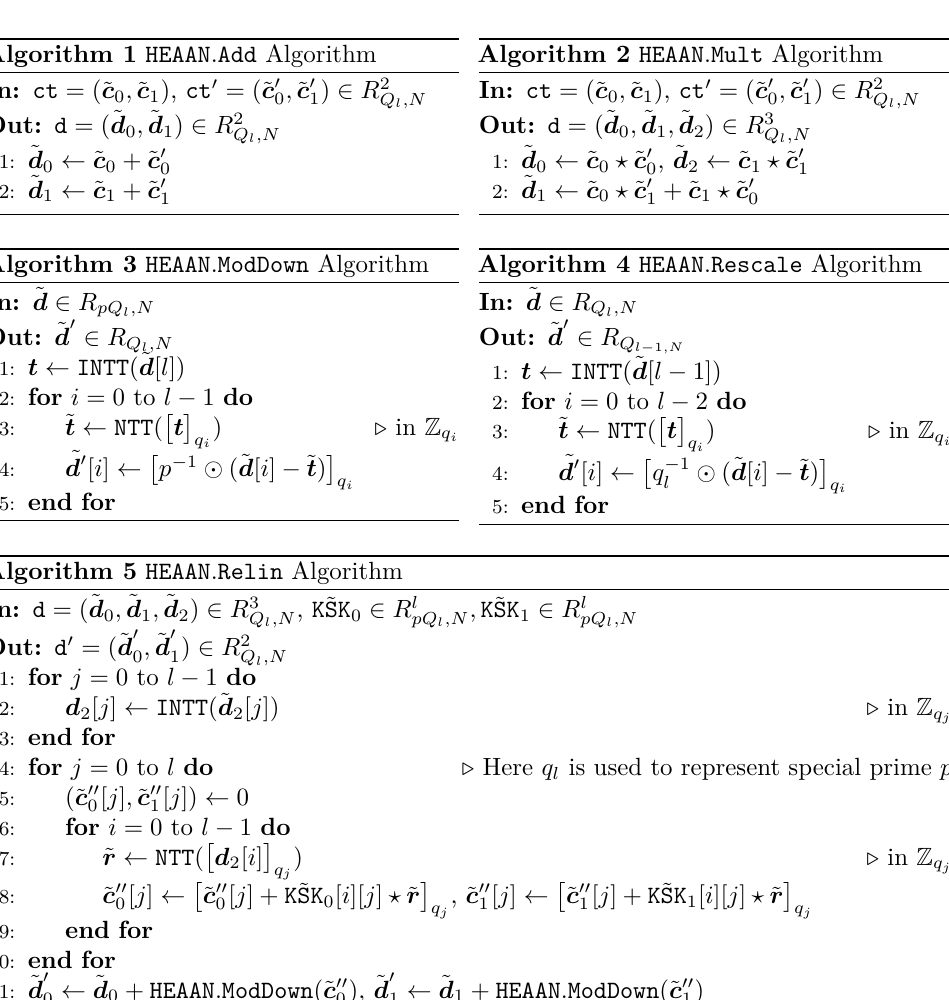
Algorithm 1 HEAAN . Add Algorithm Algorithm 2 HEAAN . Mult Algorithm